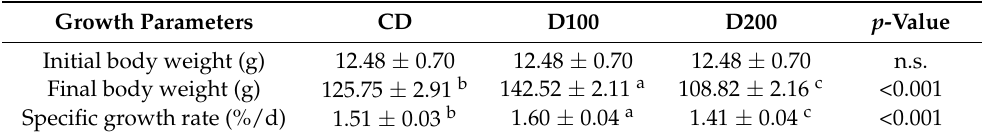
Table 3. Growth performances of sea bass fed on control diet (CD) and experimental diets